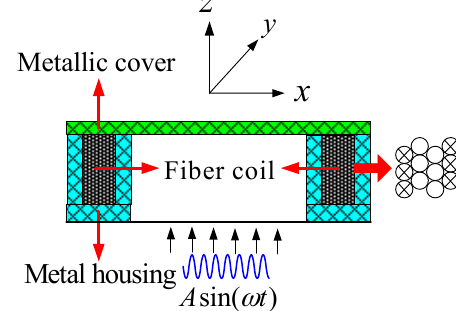
Figure 5. Diagram of the mechanical vibration applied to the fiber coil. The vibration direction is along the z -axis and perpendicular to the fiber coil.